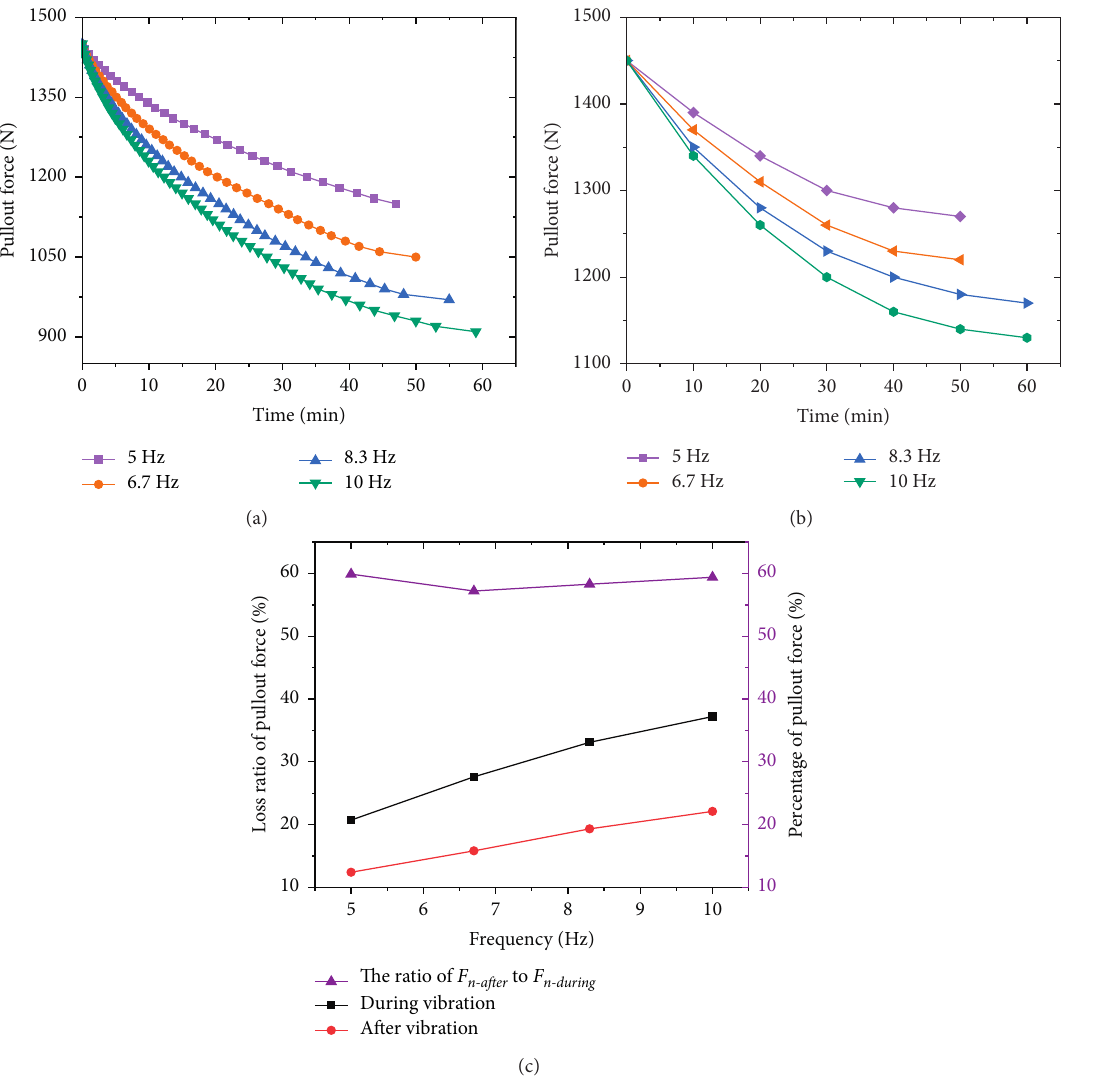
Figure 14: The variation of pullout force with time under different excitation frequencies. (a) During vibration. (b) After vibration. (c) Loss ratio of pullout